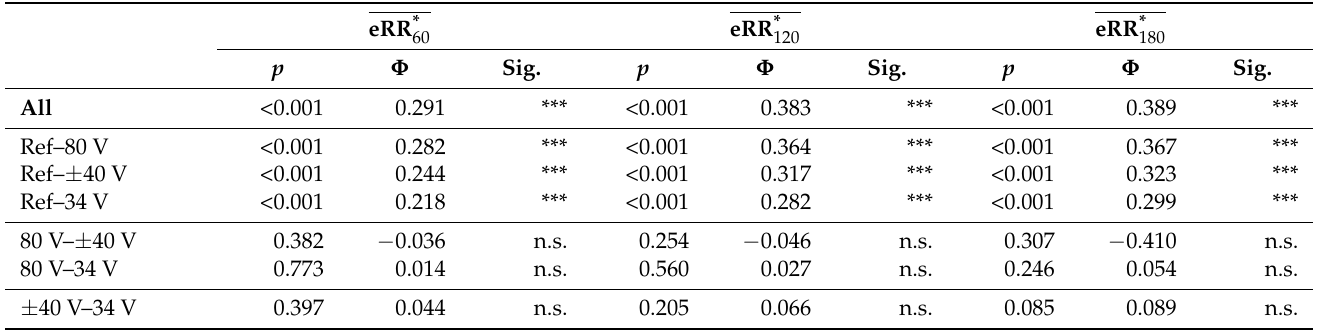
Table 4. Global and local X 2 -tests comparing the average experimental retention rates for the different treatment conditions with exclusion of initial effects and referring to the number of stocked fish. Experimental retention rates for one, two and three hours evaluation time (eRR ∗ Included are the error probability p , Φ resembling the effect size and the significance (Sig.) where n.s. denotes no significance, * p < 0.05, ** p < 0.01 and *** p < 0.001). eRR * 60